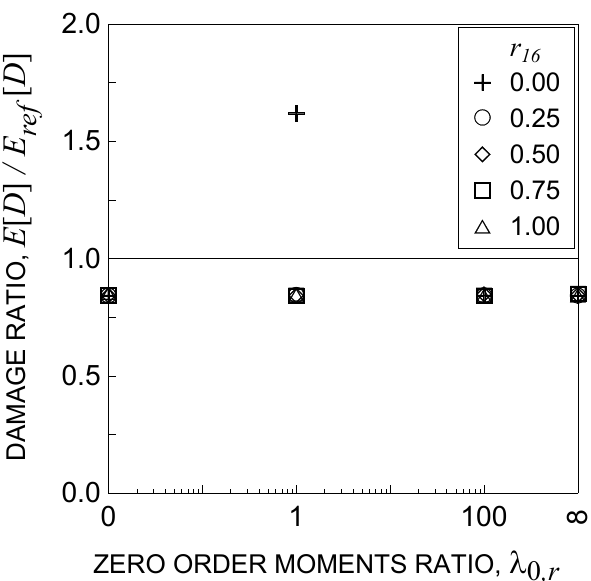
Figure 5: Comparison between [ ] E D and [ ]